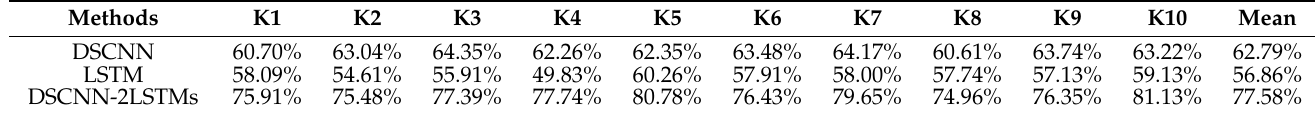
Table 8. Ablation experiment results of five-class classification task recognition by ten-fold cross-validation.